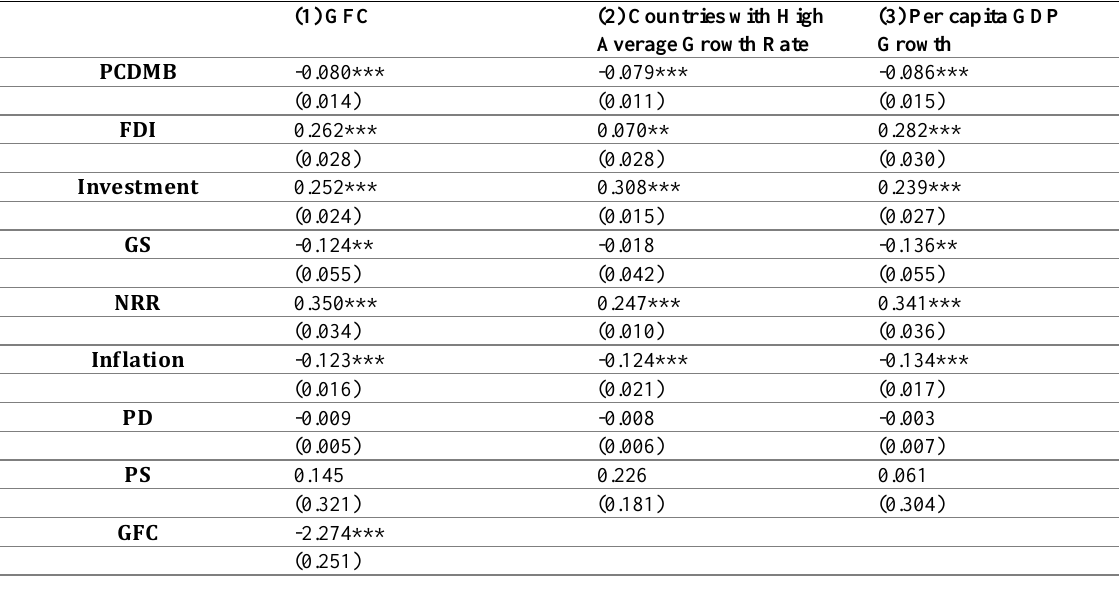
Table 4: Global Financial Crisis, Countries with High Average Growth Rate and Per Capita GDP